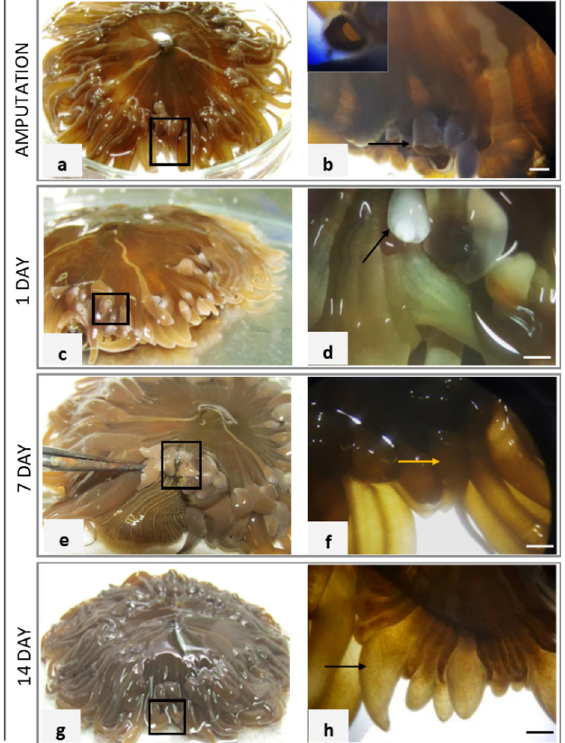
Figure 1. Morphological detection of the wound of A. viridis and regrowth of the amputated tentacles. Specimens injured in the black box area ( a ), wound area observed after 6 h with magnification of amputated tentacles indicated by the arrow ( b ). After 1 day post-amputation (dpa), the wound in the tentacles appear closed but avoid of pigment ( c ). Magnification of the closed terminal part of the tentacles with white pigmentation indicated by the arrow ( d ). At 7 dpa, the black boxed area includes the regenerated tentacles ( e ), and the small 2 mm long regrown tentacles showed a yellow–brown color like the global tentacular component ( f ). At 14 dpa, the tentacles continue to grow ( g ) in length and diameter with yellow–brown pigmentation ( h ). The arrow indicates a 4 mm long tentacle. Bar = 2 mm.